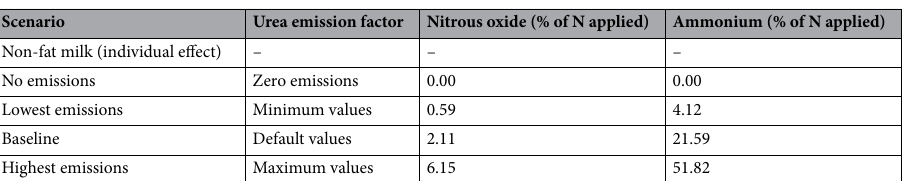
Table 1. Sensitivity analysis scenarios for potential variations of EICP on-site